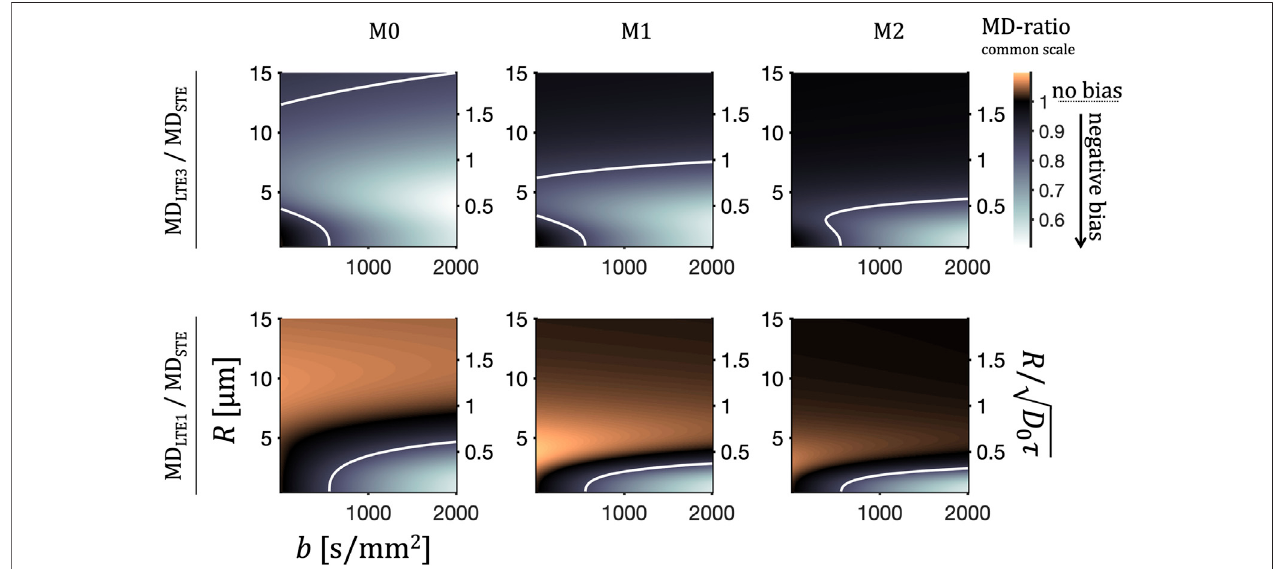
FIGURE 9 | MD bias due to anisotropy and TDD. Apparent diffusivities were calculated for cylinders and for a range of radii R and b-values as in Figure 8 . Shown are the ratios between MD values from LTE3 and STE, MD LTE3 /MD STE (upper row) and between LTE1 and STE, MD LTE1 /MD STE (bottom row) for the preclinical M0, M1 and M2waveforms (left toright),whichshown in Figure 2 . Thenormalizedsize scale isshown on the right, where the normalization constant represents acharacteristic (cid:6)(cid:6)(cid:6)(cid:6) (cid:10) ≈ 7 μ m. Contour lines are shown at 0.85. While all the ratios are unity at the low left corners, MD from STE and diffusion distance during encoding time τ and D 0 τ LTEcandeviate signi fi cantlyathigher b-valuesand intermediate sizes.ForLTE3,thedeviationoccurs foranextended sizerange evenat lowb-values (upperrow),while for LTE1, the deviation is only signi fi cant at high b-values (bottom row). Note the ratio slightly above unity in the latter case, which is consistent with experimental results shown in Figure 6 and calculations in Figure 8